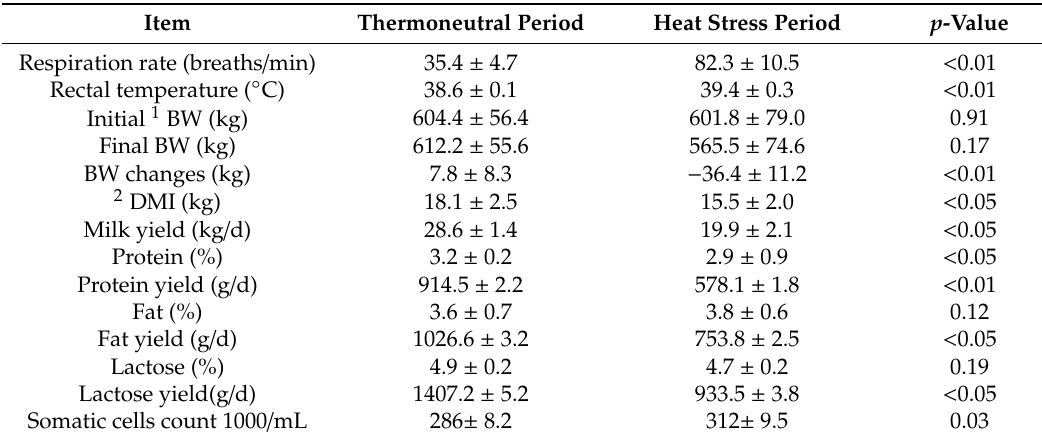
Table 3. P hysiological parameters and performance of cows reared in heat stress and thermoneutral periods (mean ± SD).